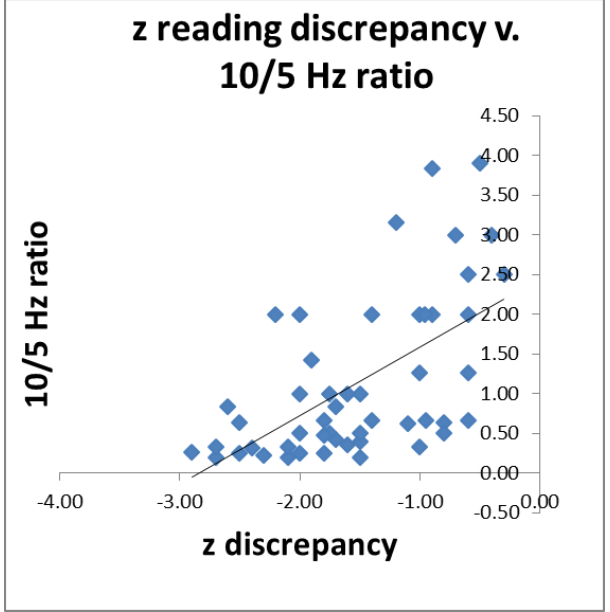
Figure 5. Reading discrepancy was predicted by 10/5 Hz ratio in 52 poor readers; r = 0.59, p < 0.01.